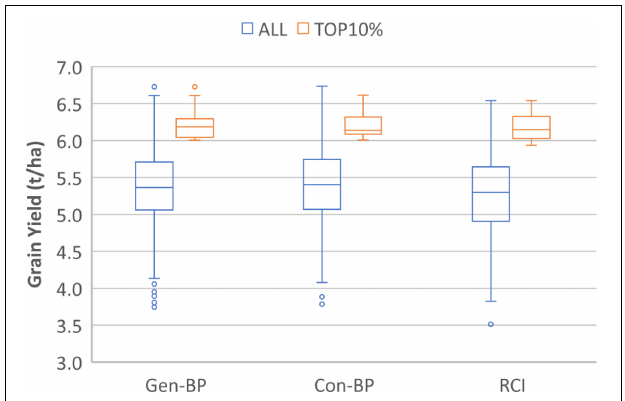
FIGURE 2 | Experiment 2. Distribution of F2-predicted breeding values (grain yield) of 213 randomly selected individuals estimated using GK (top, A ), GBLUP (Middle, B ), and rrGBLUP (low, C ) with imputed markers.